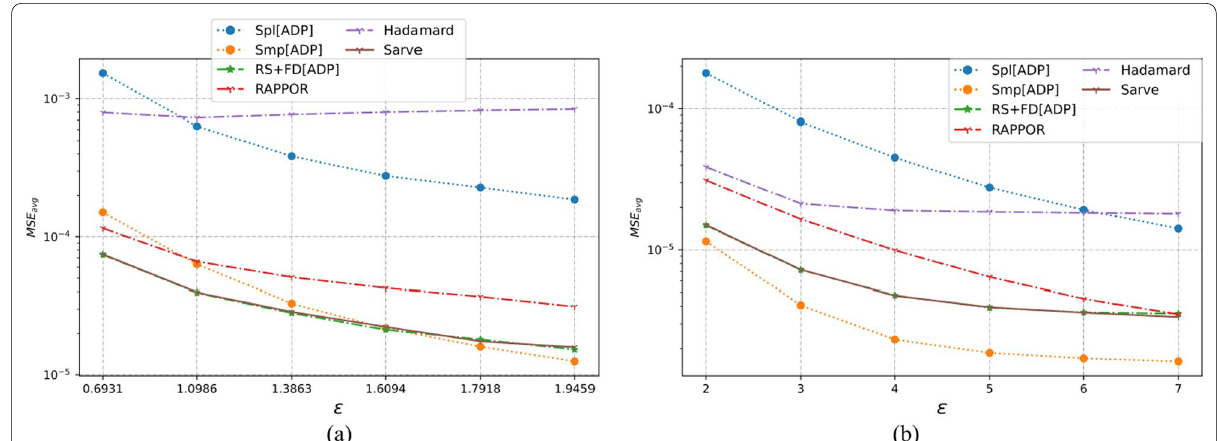
Fig. 11 The MSE averaged over 100 runs for synthetic data with N fake data under a high privacy regime, experimental setup labeled ES_Syn_4 in Table 2; b general privacy regime, experimental setup labeled ES_Syn_10 in Table 2